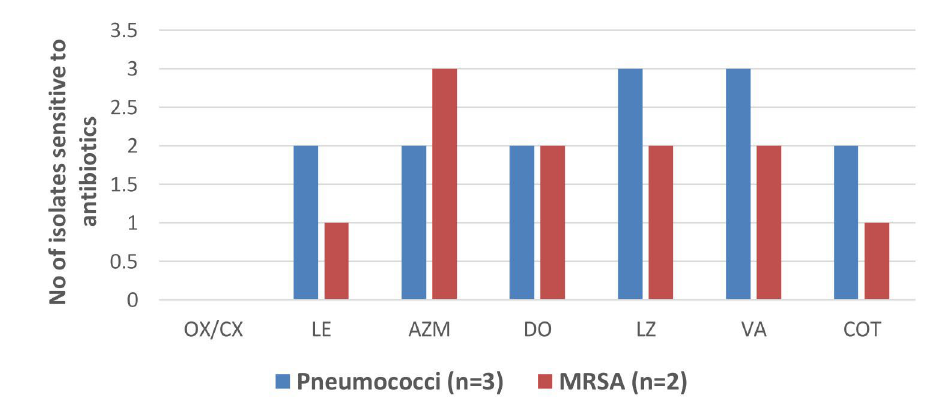
Fig. 2. Antibiotic sensitivity pattern of Gram-positive isolates from BAL fluid(n=5). OX-Oxacillin; CX=Cefoxitin: LE=Levofloxacin: AZM=Azithromycin; DO= Doxycycline; LZ=Linezolid; VA=Vancomycin: